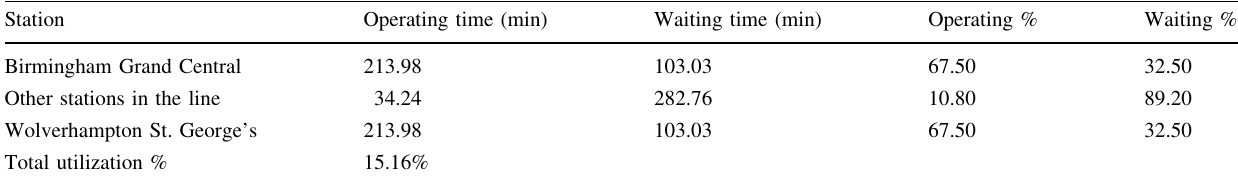
Table 5 Operating and waiting times of the system during peak hours in clockwise direction Station